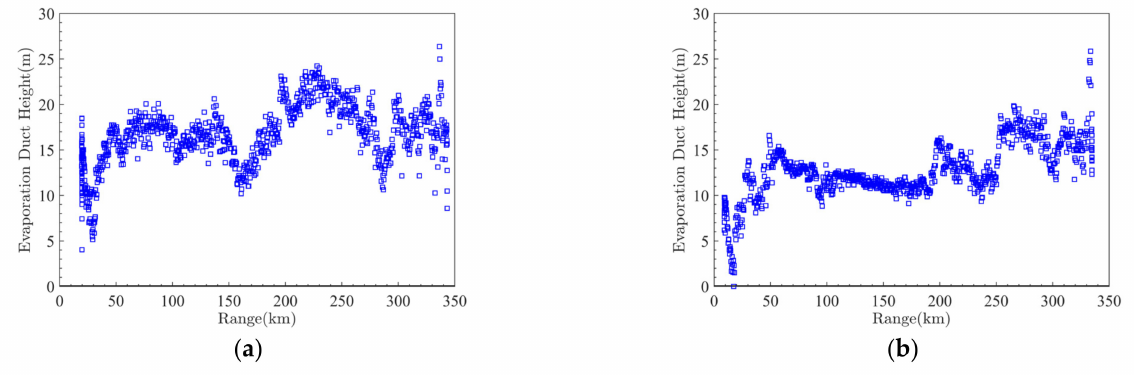
Figure 5. EDHs measured on Wenchang–Yongxing Island path: ( a ) Wenchang–Yongxing Island; ( b ) Yongxing